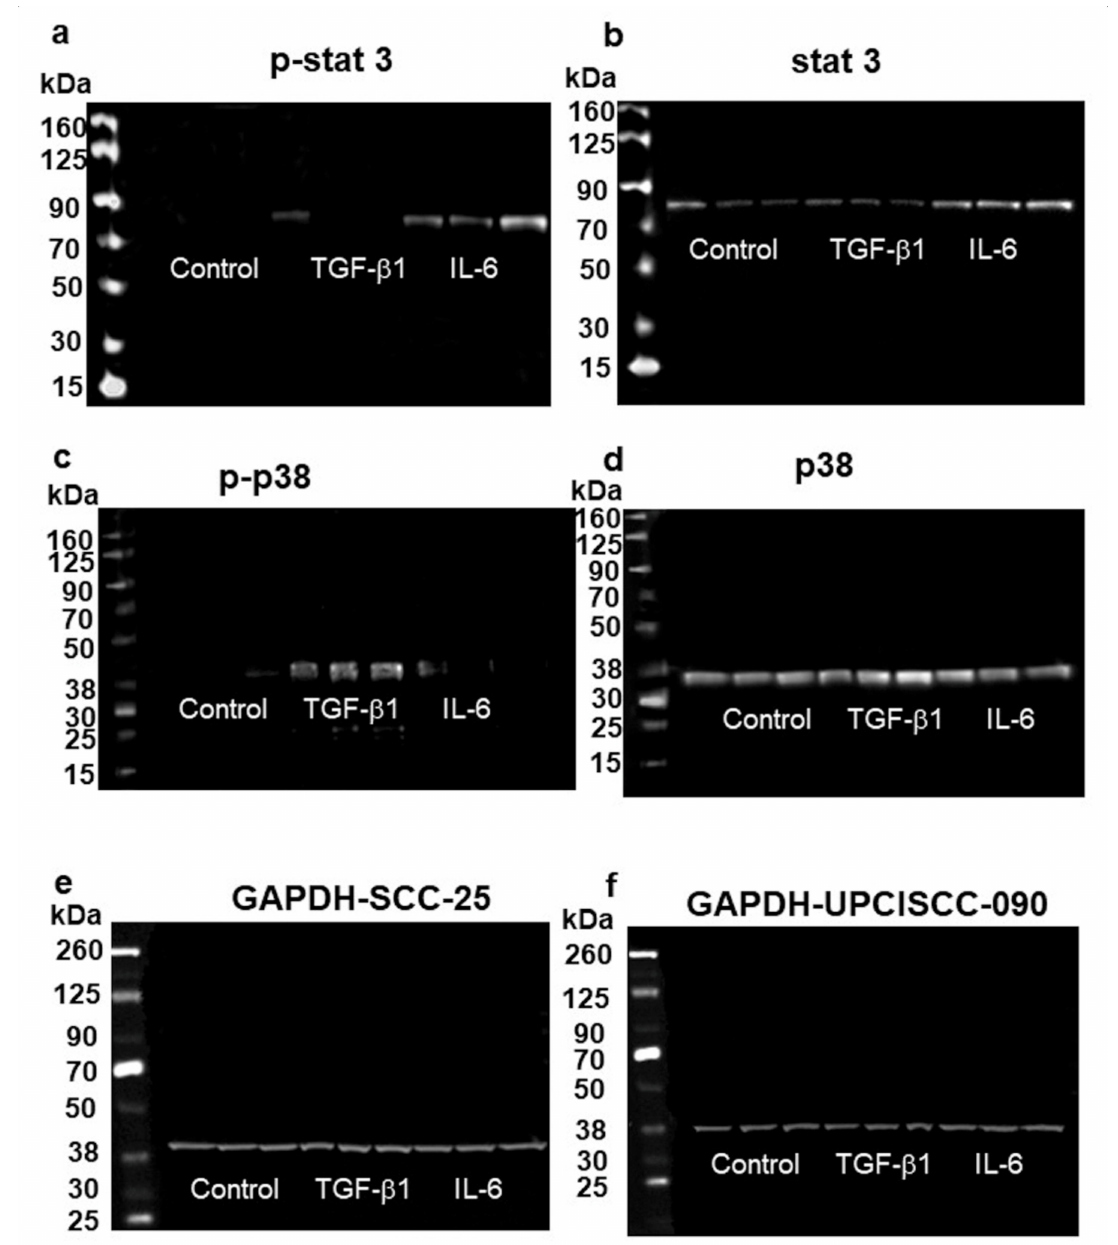
Figure 9. Western blot detection of p-stat3 ( a ), stat3 ( b ), p-p38 ( c ), p38 ( d ) proteins in SCC-25 cells in control, 1 ng/mL TGF- β 1 and in 50 ng/mL IL-6 treated conditions. GAPDH was used as loading control in both SCC-25 and UPCI-SCC90 cells ( e , f ). Phospho-stat3 (p-stat3) and stat-3 ( a , b ) were upregulated by IL-6 treatment. TGF- β 1 induced phosphorylation and activation of the estimated p38 mitogen-activated protein kinase ( c , d